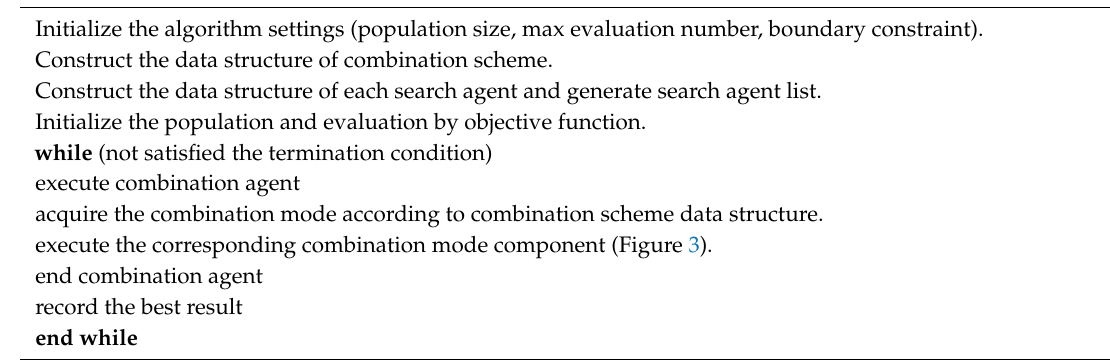
Algorithm 2. Algorithm of the